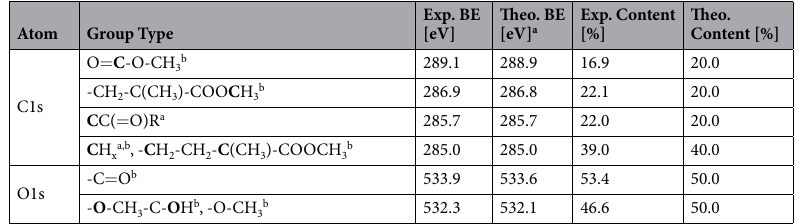
Table 1. XPS data for PMMA treated silicon thin films, along with comparison data from a Briggs, et. al . 38 and b Kaczmerak, et. al . 39 .